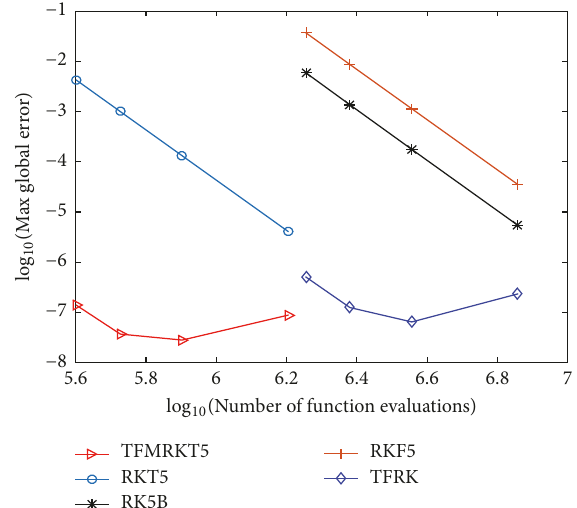
Figure 8: The efficiency curve for TFMRKT5, RKT5, RK5B, RKF5, and TFRK for Problem 9 with 𝑥 𝑒𝑛𝑑 = 10000 and ℎ = 0.025, 0.05, 0.075, 0.1 .